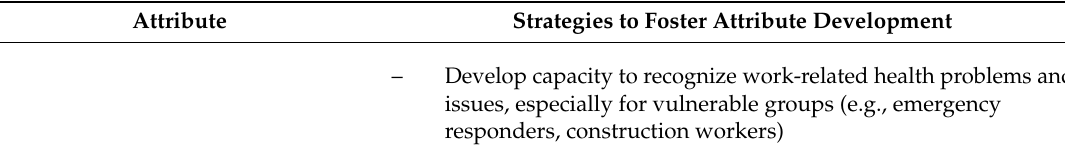
Table 3. Profile of the OSH professional of the future